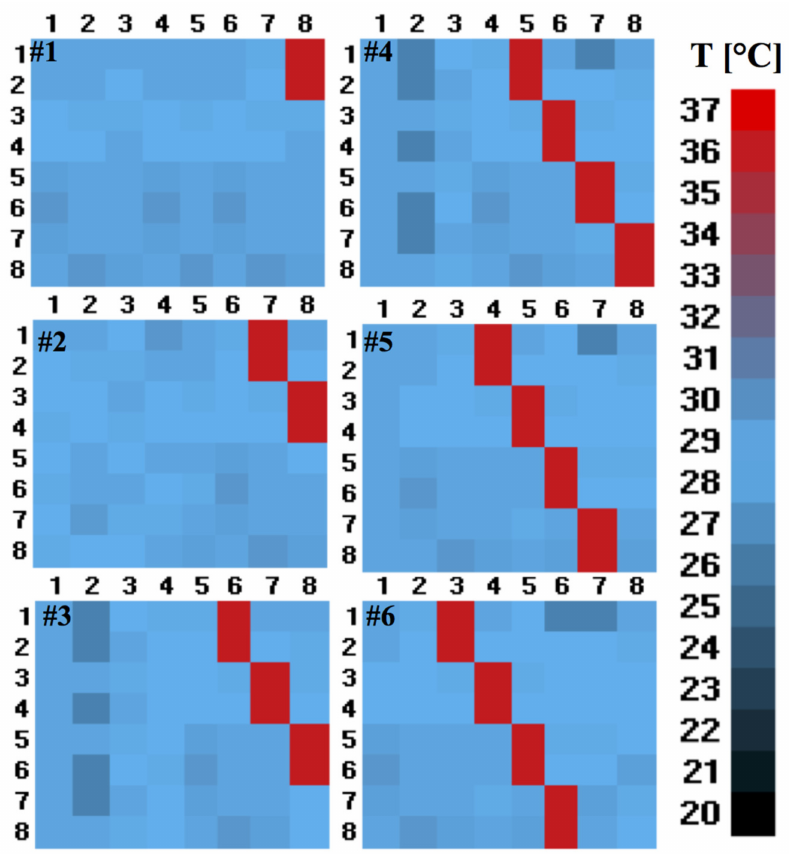
Figure 10. Representative illustration of Ramp test conducted with 6 frames. The red block represents perturbation that scrolls from the right to left